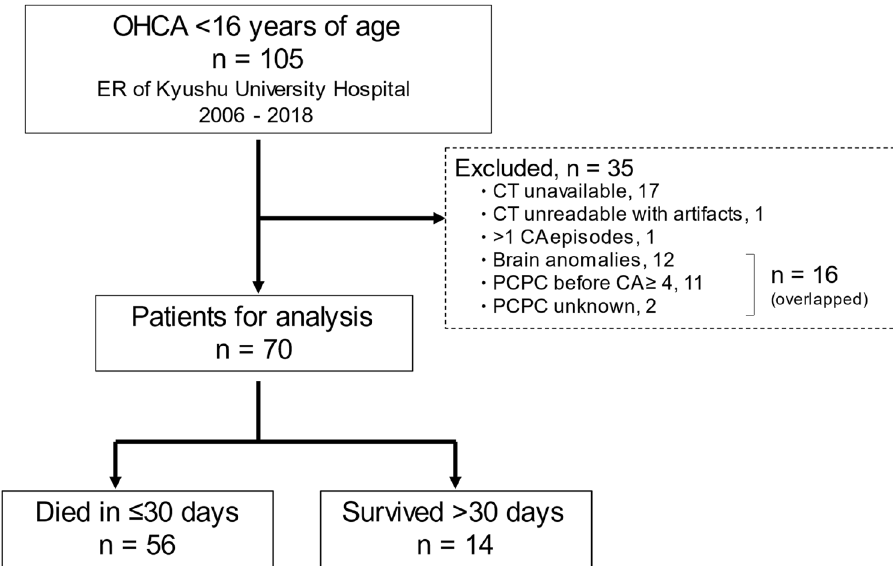
Figure 1. An overview of the present study in a flowchart. Clinical information was collected from a total of 105 pediatric cases with “out-of-hospital cardiac arrest” (OHCA). Ineligible populations (n = 35) were excluded from this study for the indicated reasons: cases without CT data available, only low-quality CT data available, more than one episode of cardiac arrest (CA), brain anomalies, severe neurological disabilities (PCPC ≥ 4) before CA or unknown neurological outcomes. Head CT findings were thus analyzed for the 70 eligible patients. Patients who survived or died were classified according to their outcomes at the primary endpoint of 30 days after CA. PCPC: Pediatric Cerebral Performance